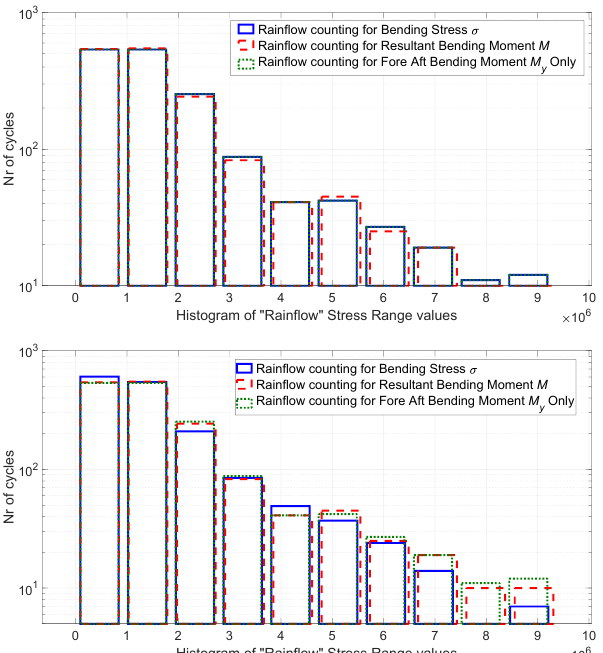
Figure 17. Histograms of 10 min bending stress σ , resultant bending moment M , and fore-aft bending moment M y time series for above-rated mean wind speed (22 m/s) set θ = 0 ◦ , τ = 0 ◦ ( above ), set θ = 60 ◦ τ = 30 ◦ ( below